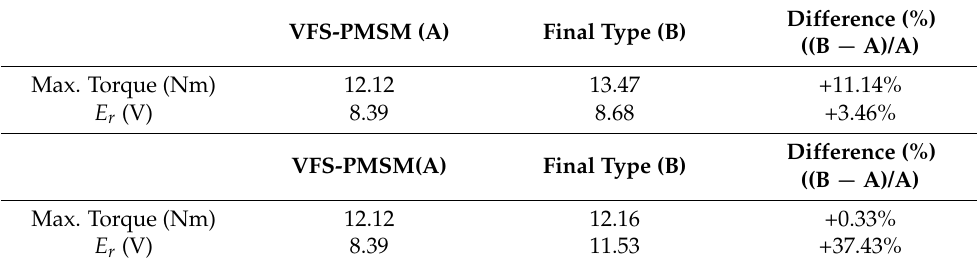
Table 5. Comparison of maximum torque and E r between final type and isotropic VFS-PMSM.